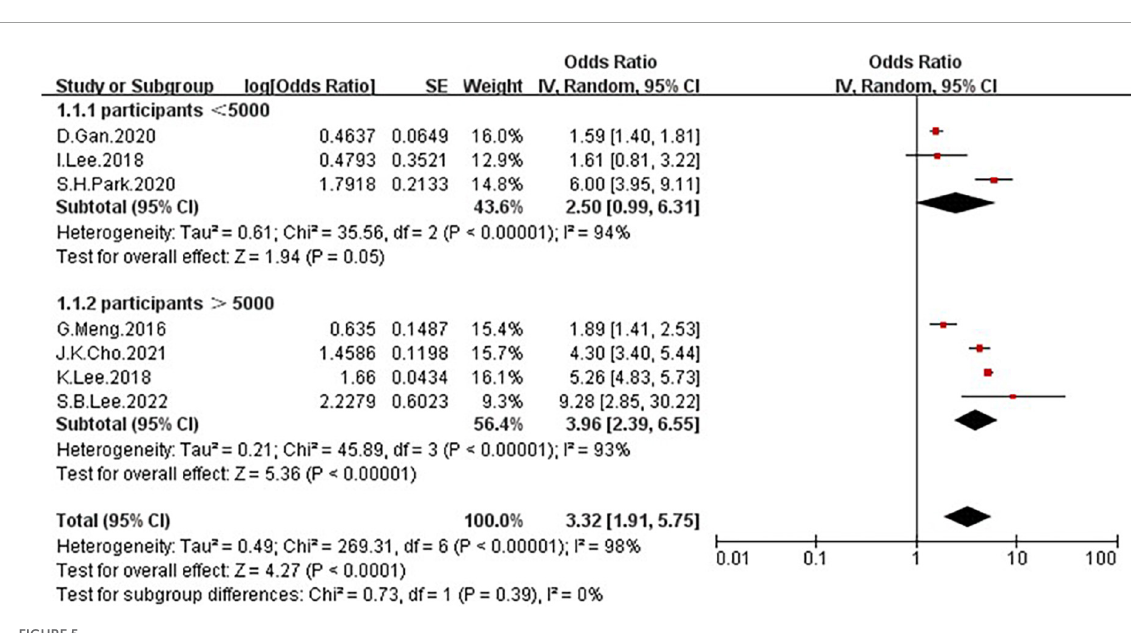
FIGURE5 Forest plots depicting the association of low grip strength and the risk of NAFLD were subgrouped by several